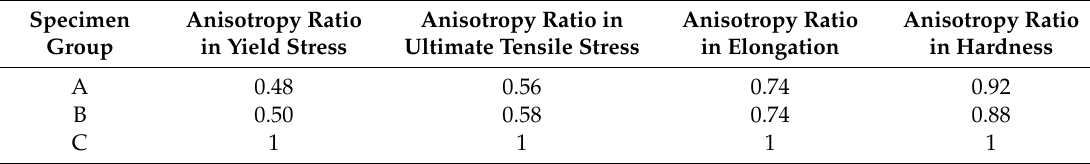
Table 5. Summary of anisotropy in mechanical properties with various build